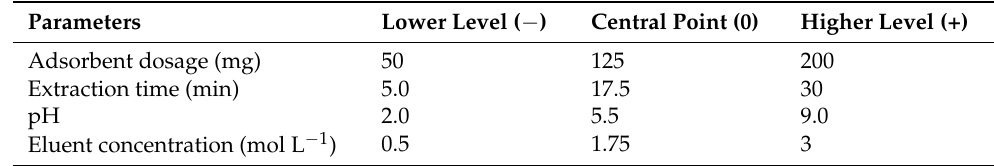
Table 1. Range of independent